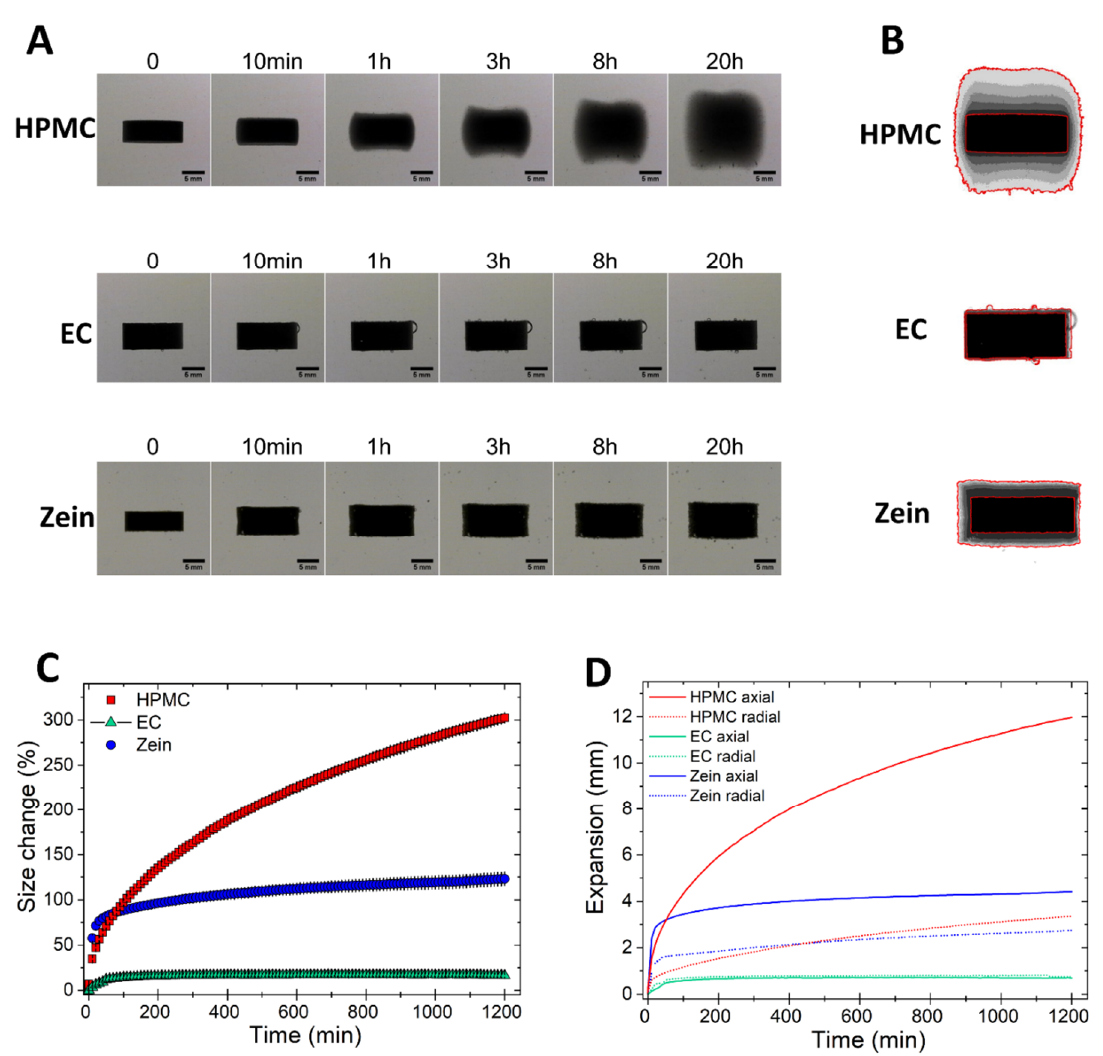
Figure 1. Swelling of tablets of pure HPMC, EC, and zein. ( A ) Image sequence of tablet swelling. ( B ) Sum of Z-stack of images. The two red lines are the outlines of the tablet at time 0 and at 20 h. ( C ) Swelling measured as the change of the projected area of tablets (mean ± SD, n = 3) as a function of time. ( D ) Axial and radial swelling of tablets (mean ± SD, n = 3) as a function of time.